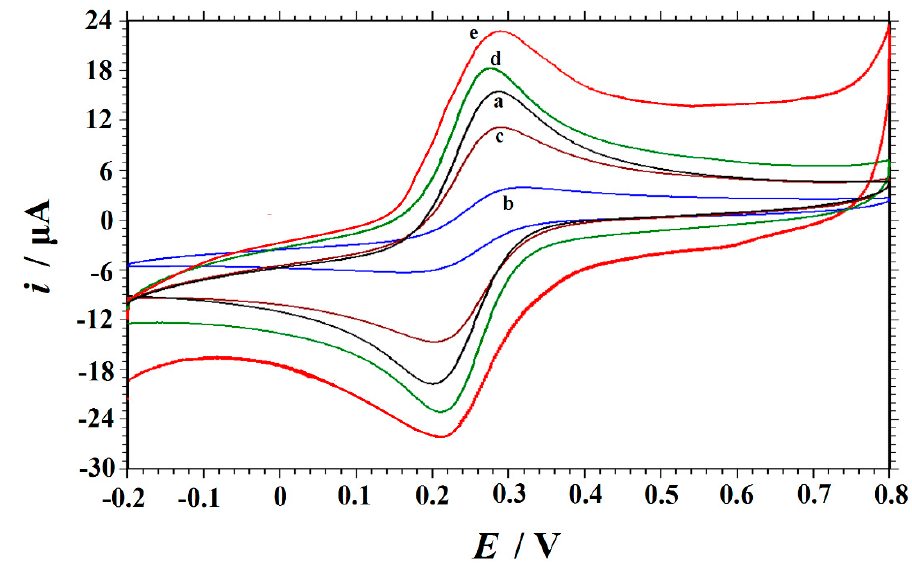
Figure 3. Cyclic voltammograms obtained on (a) GCE, (b) GO / GCE, (c) Cu 2 O–GO / GCE, (d) ERGO / GCE and (e) Cu 2 O–ERGO / GCE in a solution of 1.0 mM K 3 [Fe(CN) 6 ] and 0.5 M KCl at the scan rate of 0.1 V s − 1 .